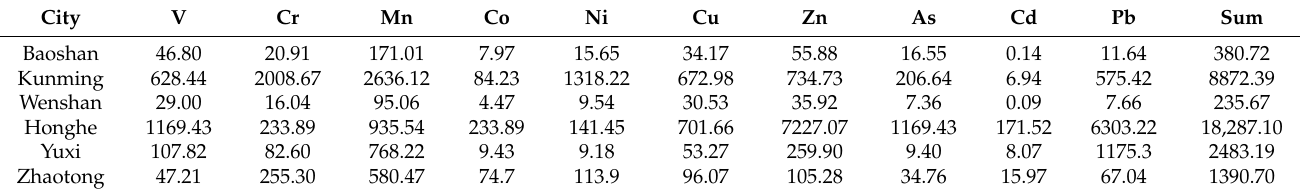
Table 5. Potentially toxic elements emissions in PM 2.5 of soil fugitive dust in 2018